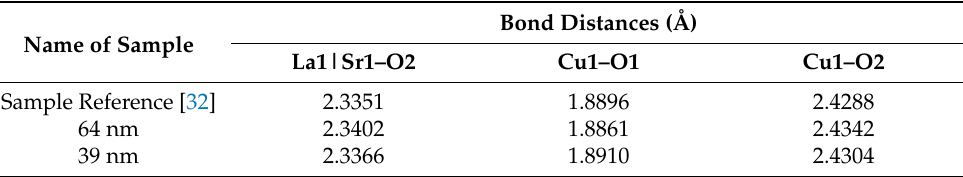
Table 3. Selected bond distances for La 2 − x Sr x CuO 4 nanoparticles with x =